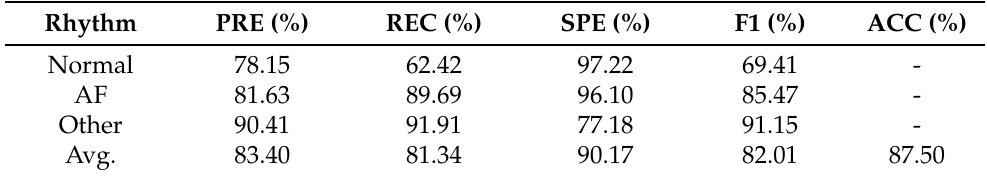
Table 6. Classification performance using MCNN-BLSTM ( l = 25 s) on the China Physiological Signal Challenge